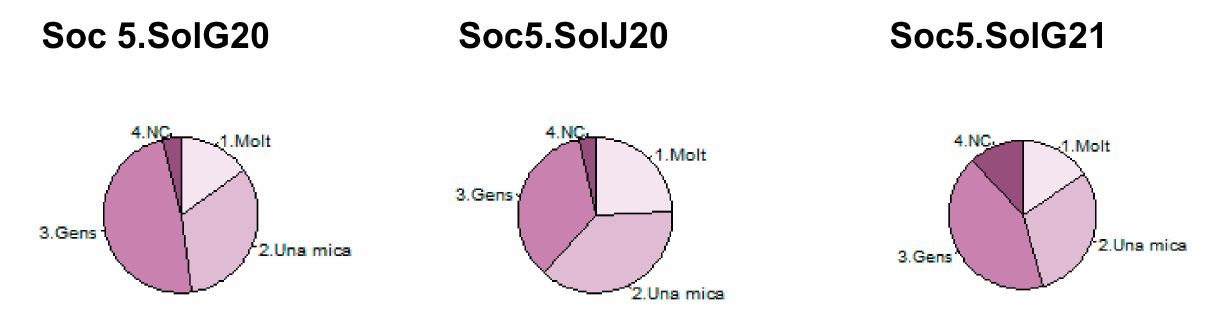
Figure 42. Grid of pie charts for loneliness